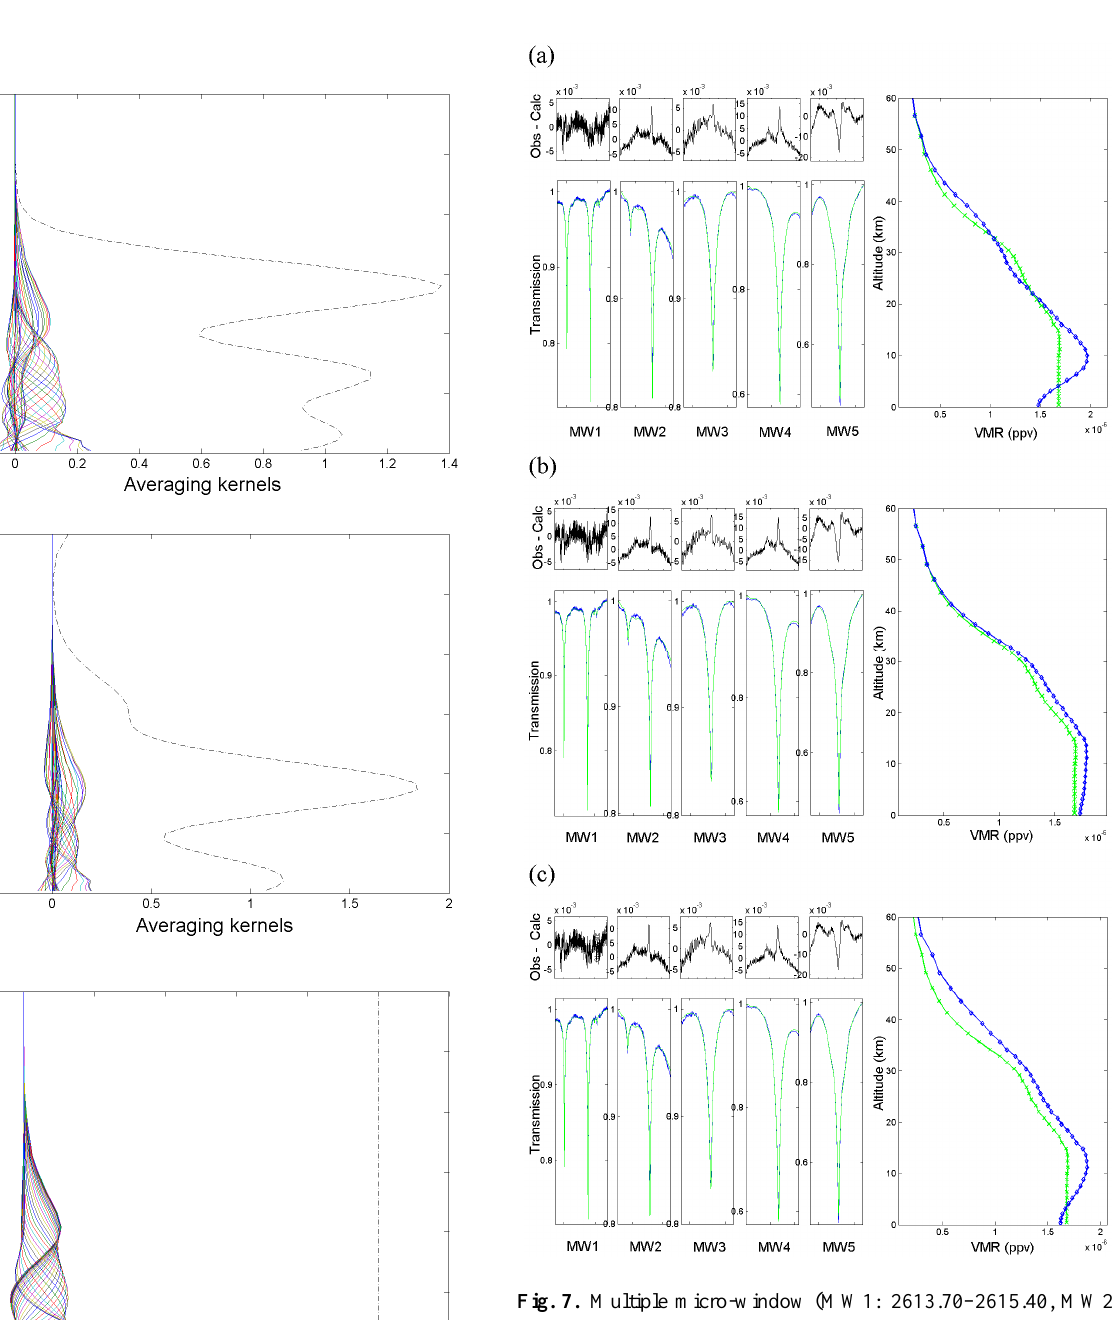
Figure 6. Averaging kernels and sensitivity curve (black dashed) for the N from a single spectrum on October 8, 2007 at St.-Denis using the (a) OEM, (b) IOA and (c) TR.